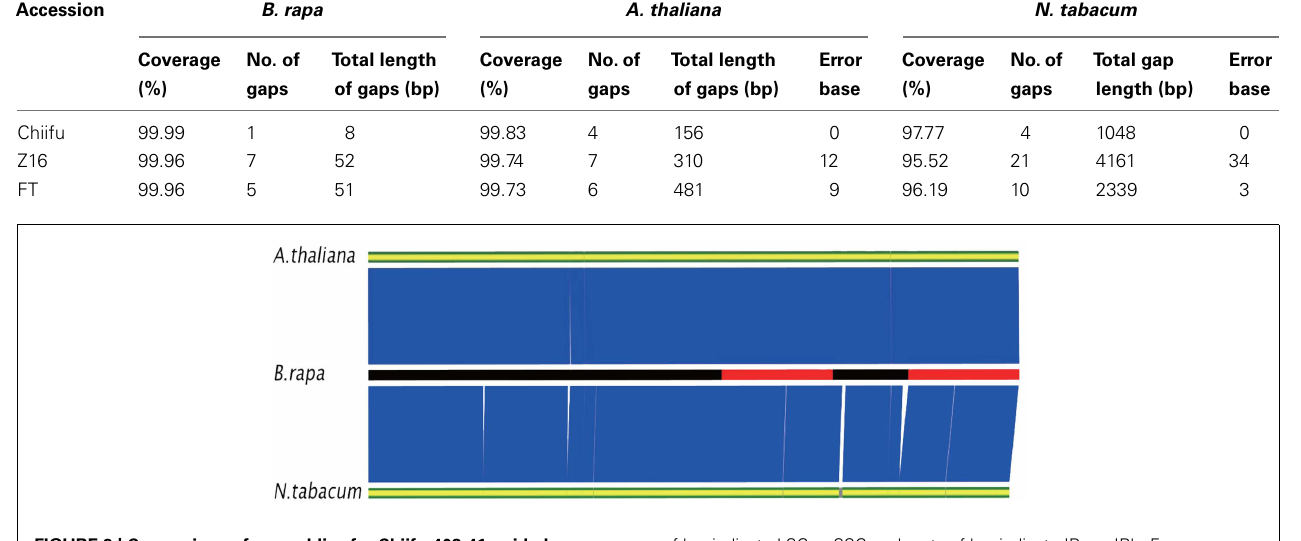
FIGURE 3 | Comparison of assemblies for Chiifu-402-41 guided by chloroplast genome sequences of B. rapa (DQ231548), A. thaliana (NC000932), and N. tabacum (NC001879). Assembled consensuses are represented by three bars. For B. rapa , black parts